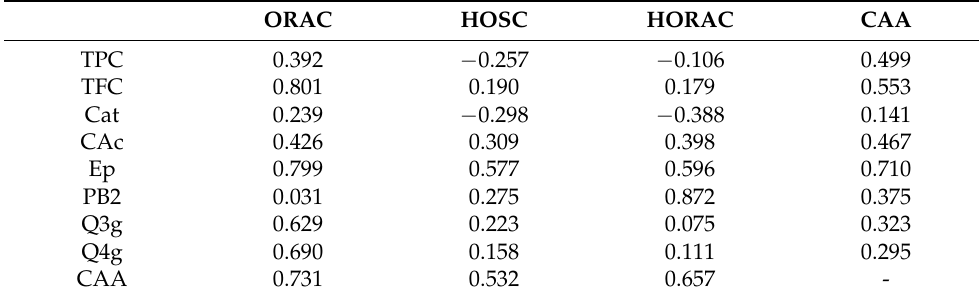
Table 2. Correlation coefficients between phenolic content and antioxidant activity of BE apple residues